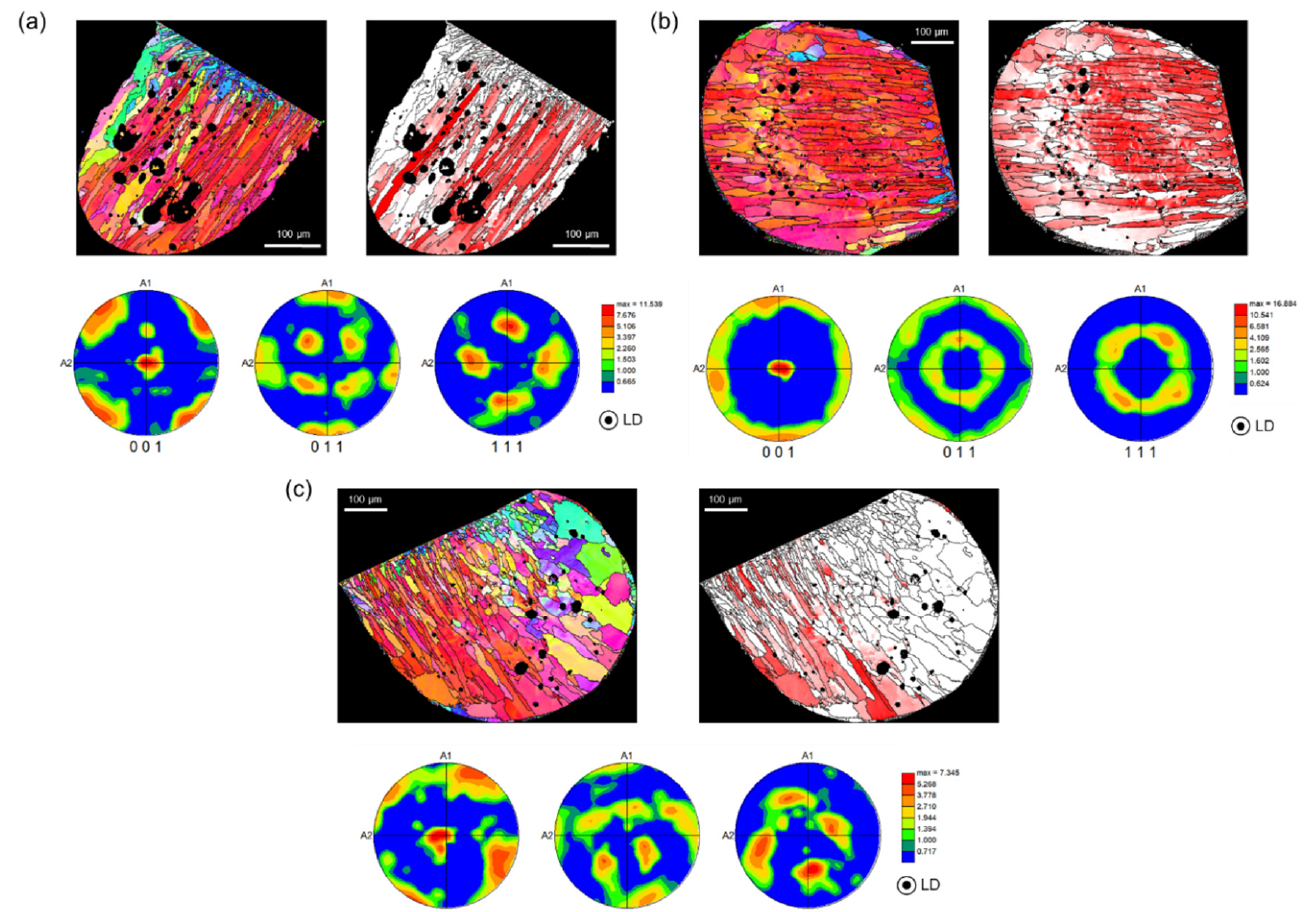
Figure 4. ( a ) Longitudinal direction (LD) orientation maps, ( b ) crystal direction maps of (001)//LD, and ( c ) pole figures of PABs of three representative specimens.